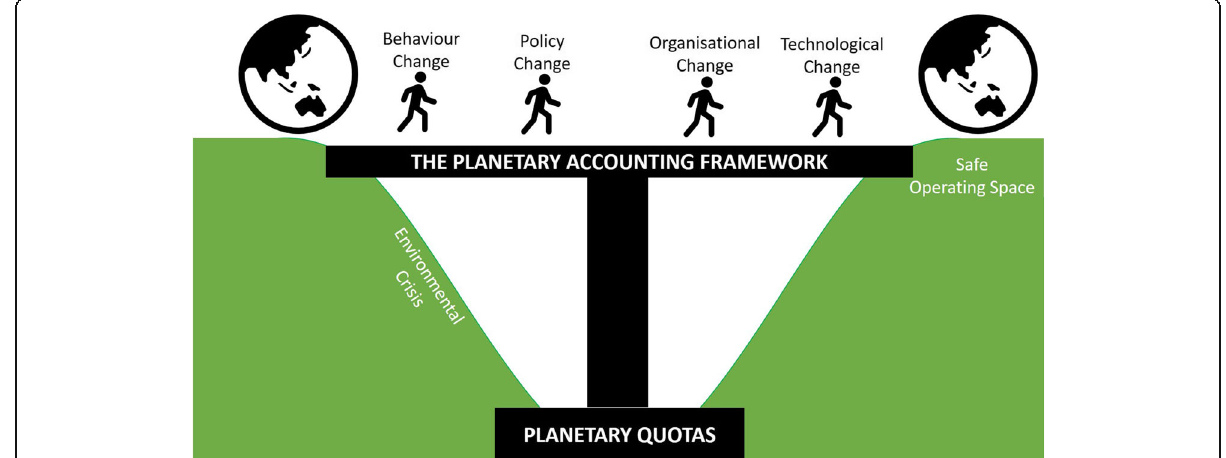
Fig. 2 The Planetary Quotas form the foundations of the Planatery Accounting Framework; a platform for